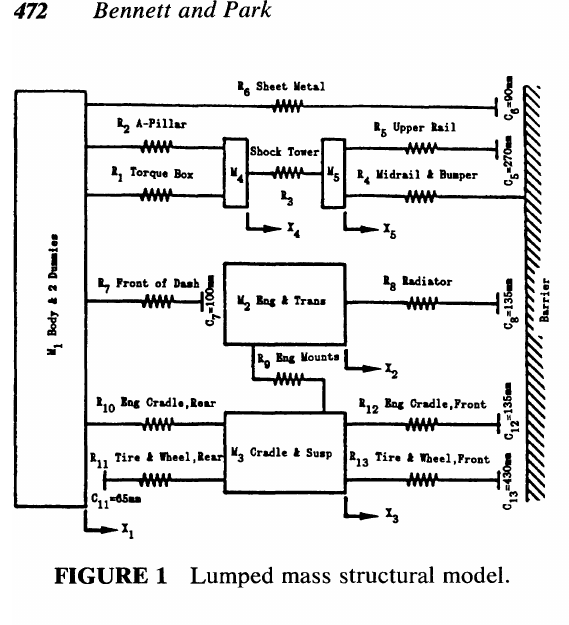
FIGURE 2 Lumped parameter occupant model with air cushion.